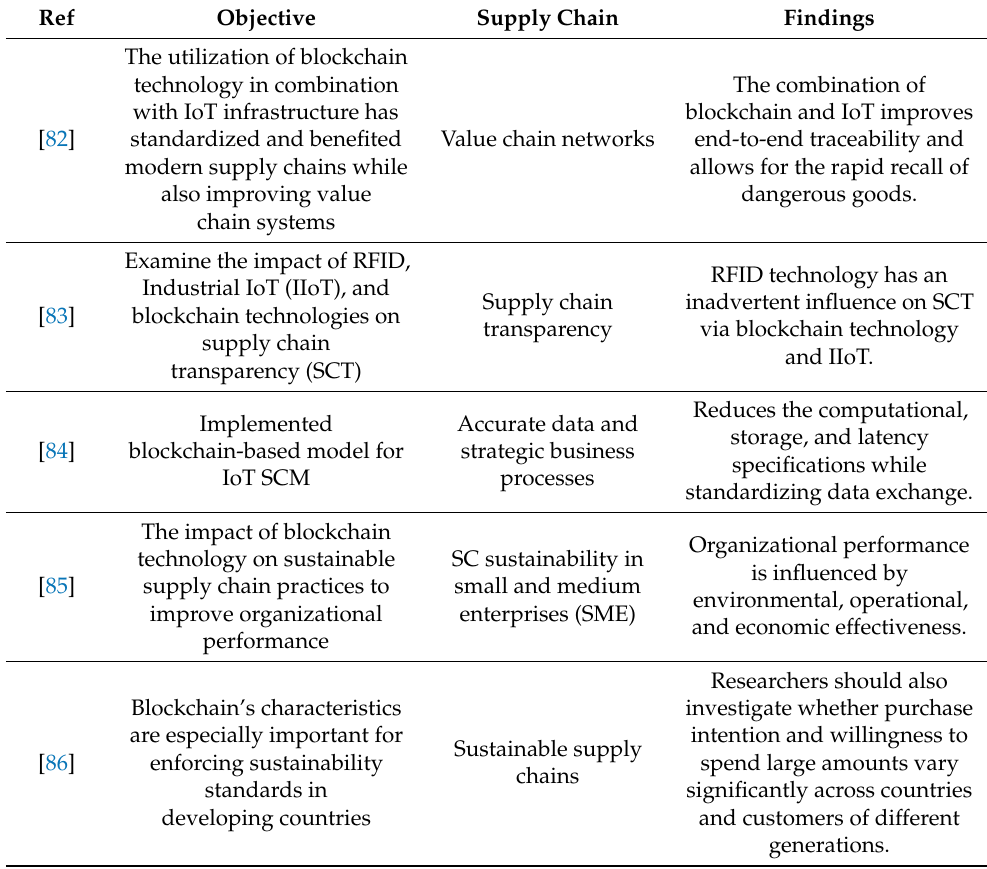
Table 4. Blockchain for sustainable